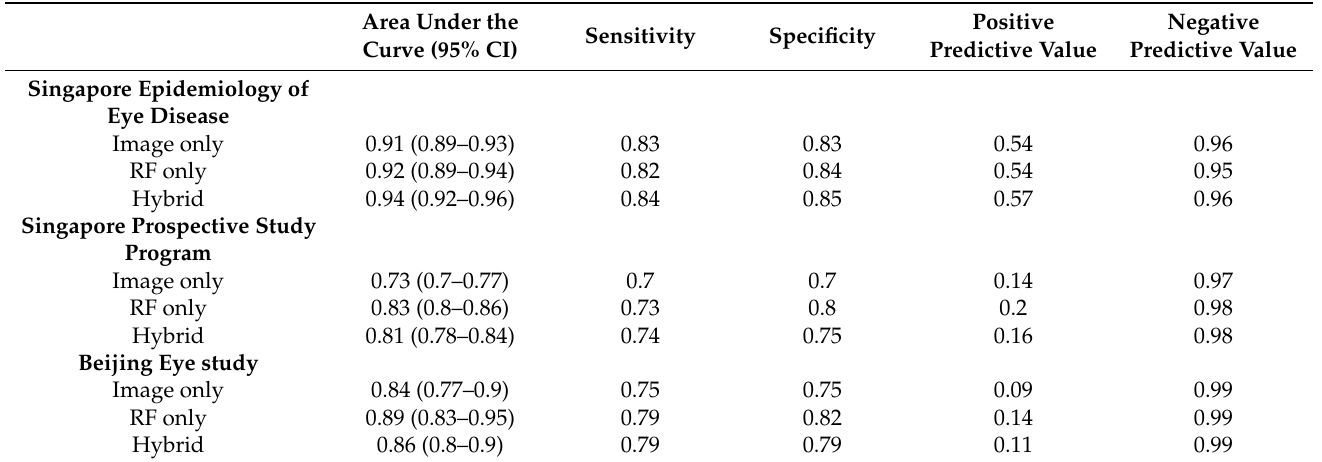
Positive Negative Predictive Value Predictive